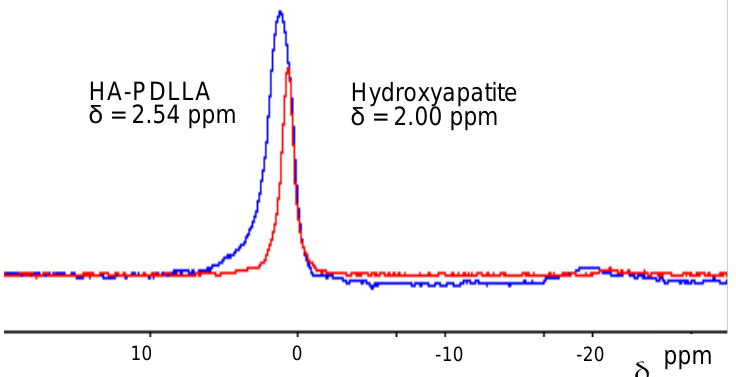
Figure 5. 31 P magic-angle spinning (MAS)-NMR of HA-PDLLA 10 (blue line) and HA (red line).